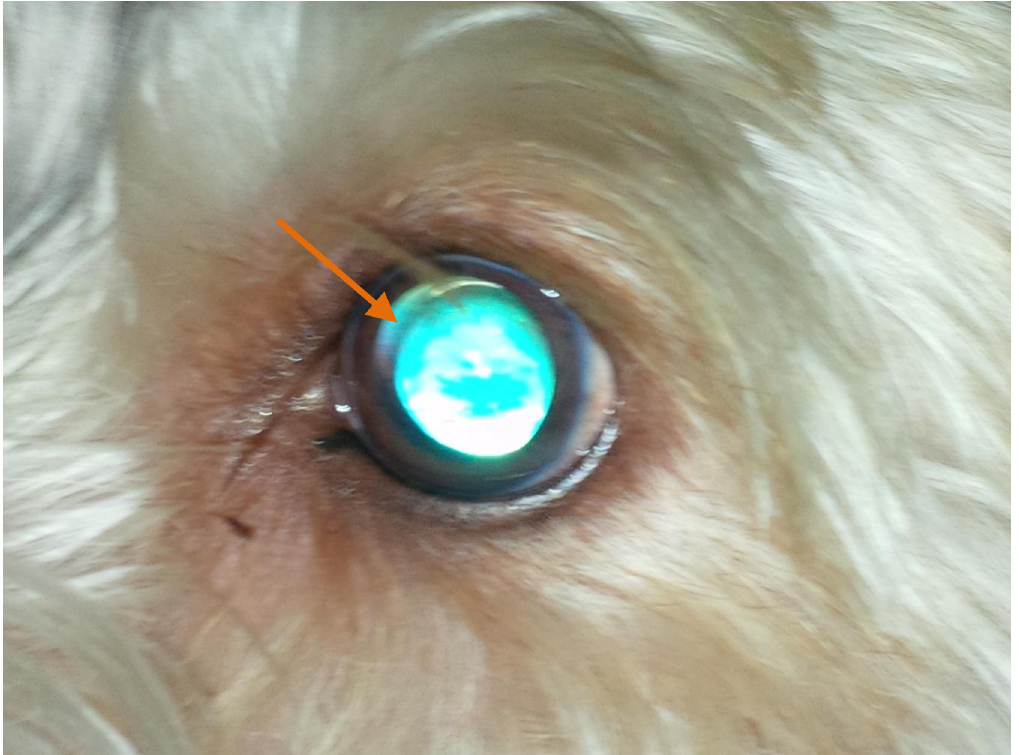
Fig 1. POAG case eye image. Left eye, 4 year old male PBGV: The eye is normotensive (18 mm. Hg.), but an aphakic crescent indicating lens subluxation is visible within the dorsal part of the dilated pupillary aperture.